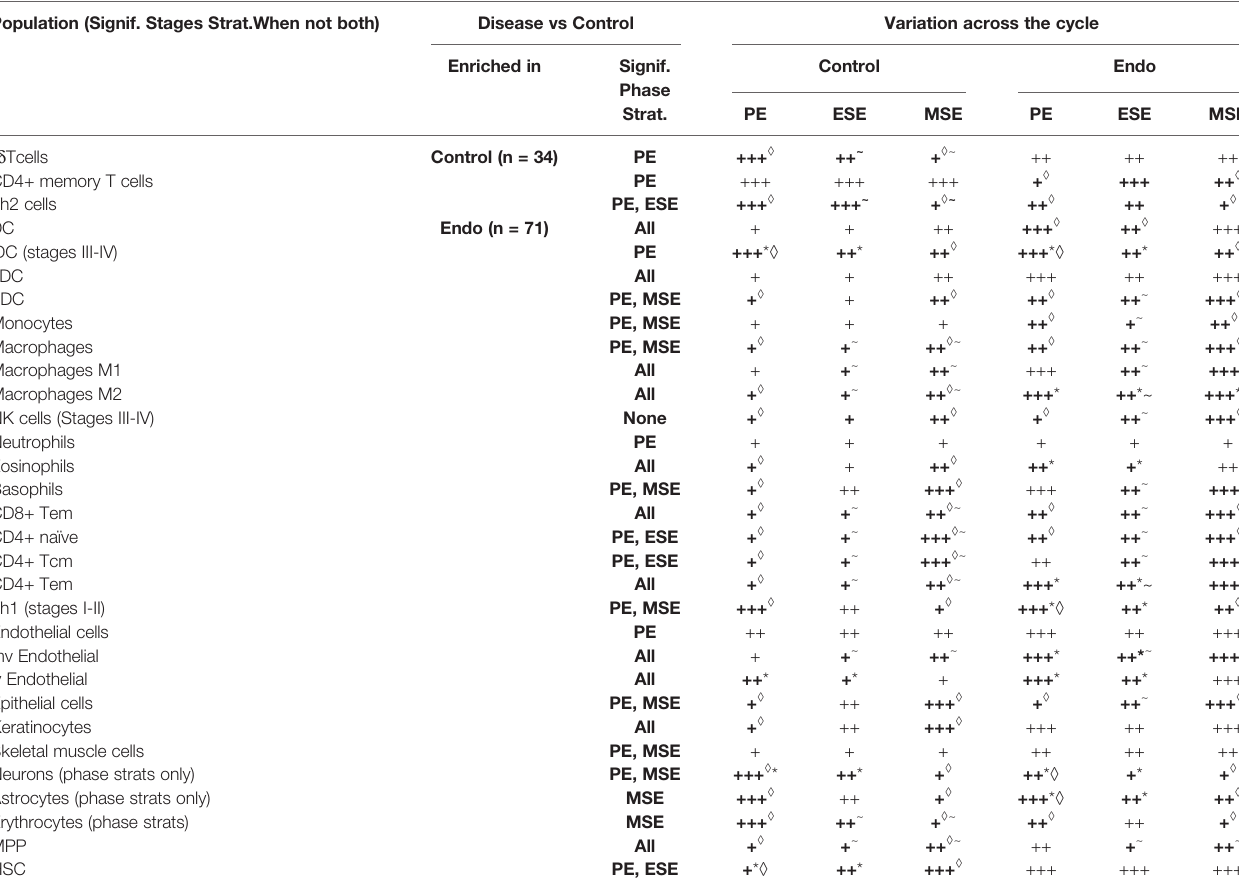
TABLE 2 | Enrichment of cell types in each condition and menstrual phase and their fl uctuation throughout the menstrual cycle. Population (Signif. Stages Strat.When not both) Disease vs Control Variation across the cycle Enriched in